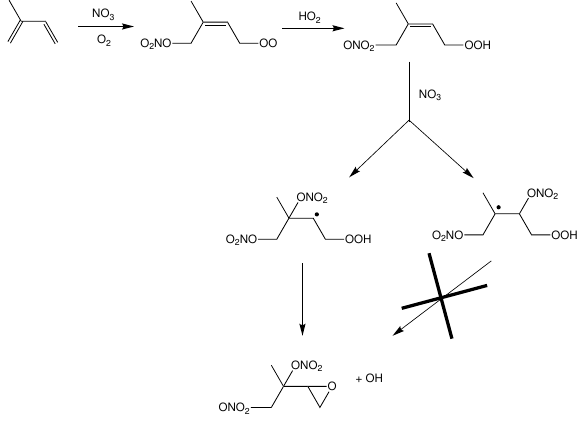
Fig. 7. Formation mechanism of dinitrooxyepoxide and hydroxyl radical from oxidation of nitrooxyhydroper- oxide.